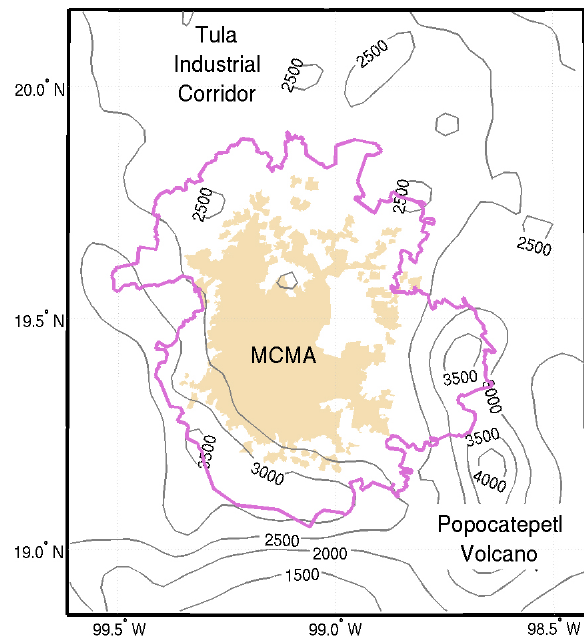
Fig. 1. Location of the Tula industrial corridor, urban area of the MCMA in beige. Terrain contours every